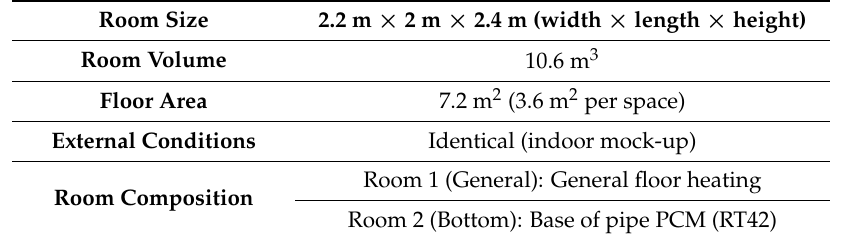
Table 2. Characteristics of the model rooms used to test the proposed floor heating system. Room